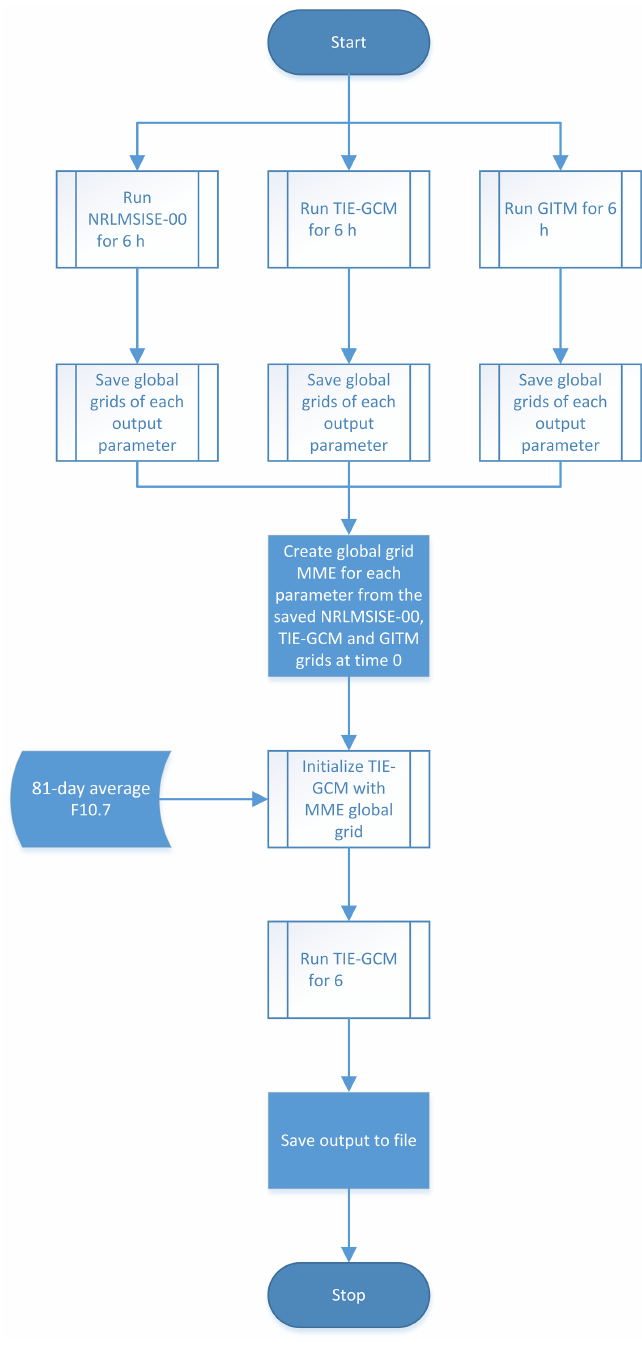
Figure 12. Flow chart of the procedure for running TIE-GCM using the MME as its initial conditions for a 6h